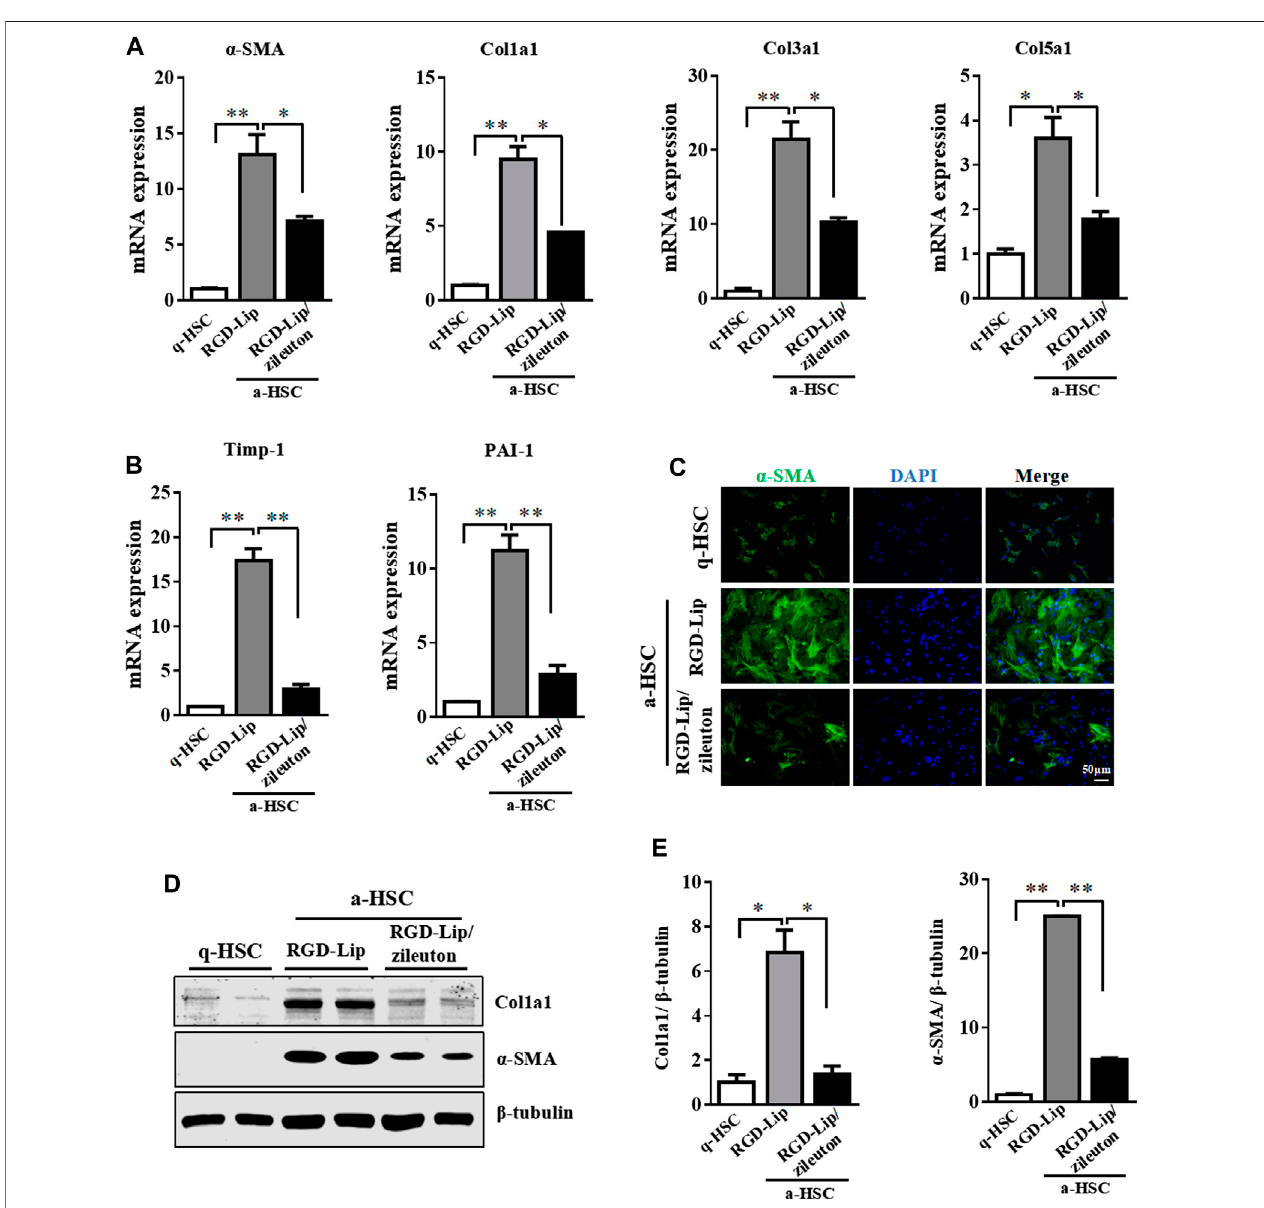
FIGURE 6 | Pharmacological inhibition of 5-LO suppressed activation of HSC. Primary HSC were isolated from WT mice and cultured in DMEM with high glucose and 10% heat-inactivated fetal bovine serum for 2 days (q-HSC) or 7 days (a-HSC). Primary HSC were treated with RGD-Lip or RGD-Lip/zileuton for 48 h (A,B) qRT- PCRanalysisofeffectofRGD-Lip/zileutontreatmentonthemRNAexpressionof fi broticgenes. (C) Immuno fl uorescenceanalysisofeffectofRGD-Lip/zileutontreatment on α -SMA expression. (D,E) Western blot analysis of α -SMA and Col1a1 protein levels in q-HSC and a-HSC. Data are mean ± SEM, n (cid:2) 5, * p < 0.05, ** p < 0.01.